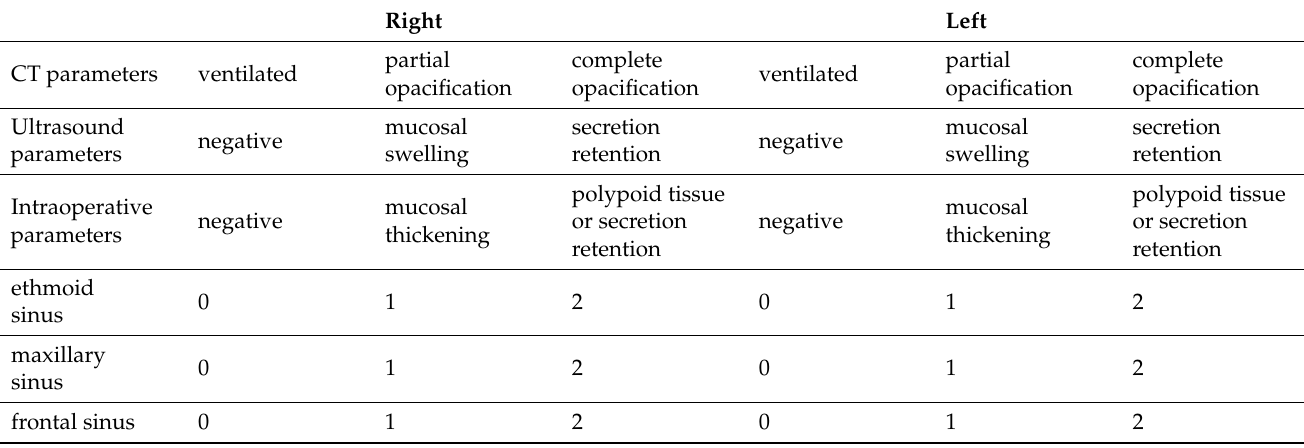
Table 1. Evaluation of preoperative CT scan, preoperative ultrasound, and findings in surgery. Right